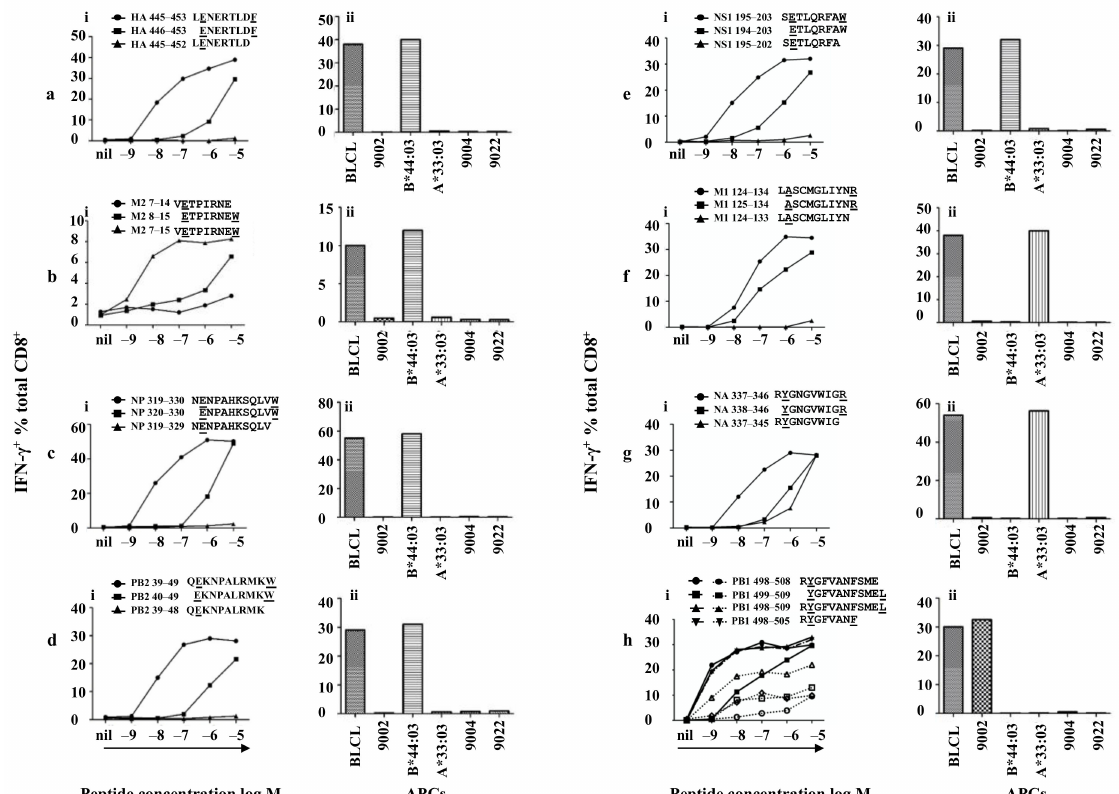
Figure 4. Minimal epitopes of differing lengths are presented by HLA-B*44:03, HLA-A*33:03 and HLA-A*24:02. Peptide- specific CD8 + T cells were established as described in the legend to Figure 1b ( a – h ) various CD8 + T cell specificities were assessed via standard ICS for the production of IFN- γ with different peptides and APCs. ( i ) peptide titrations of the minimal peptides and their truncated peptides, ( ii ) HLA restrictions of each minimal epitope. ( a – g ) peptide titrations conducted in the absence of FCS, ( h ) PB1 peptide titrations conducted in the presence of FCS (shown in solid lines) or absence of FCS (shown in dotted